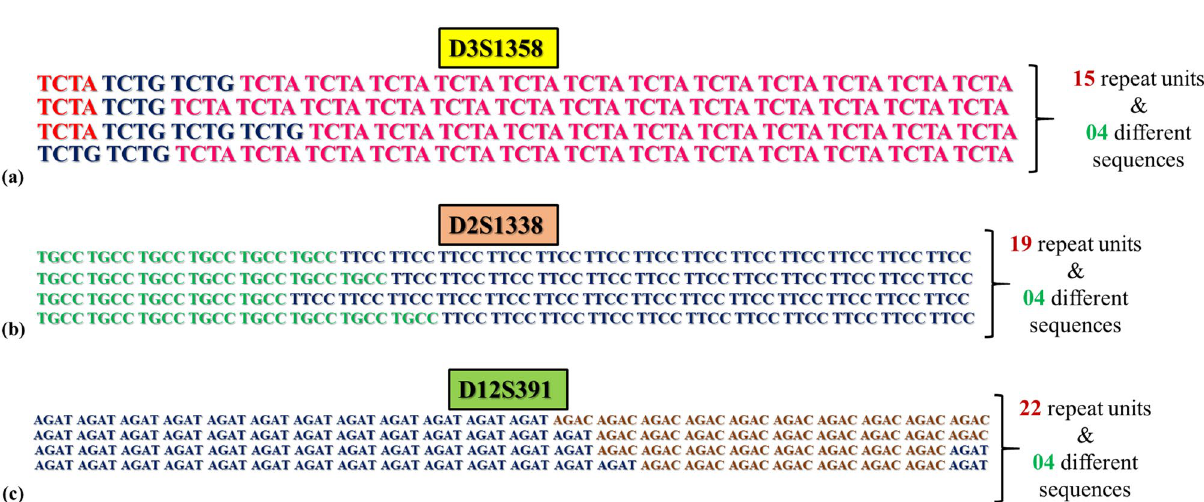
Figure 4. A representative image showing allele sequence variations with the same length ( a ) 15 repeats at D3S1358, ( b ) 19 repeats at D2S1338, and ( c ) 22 repeats at